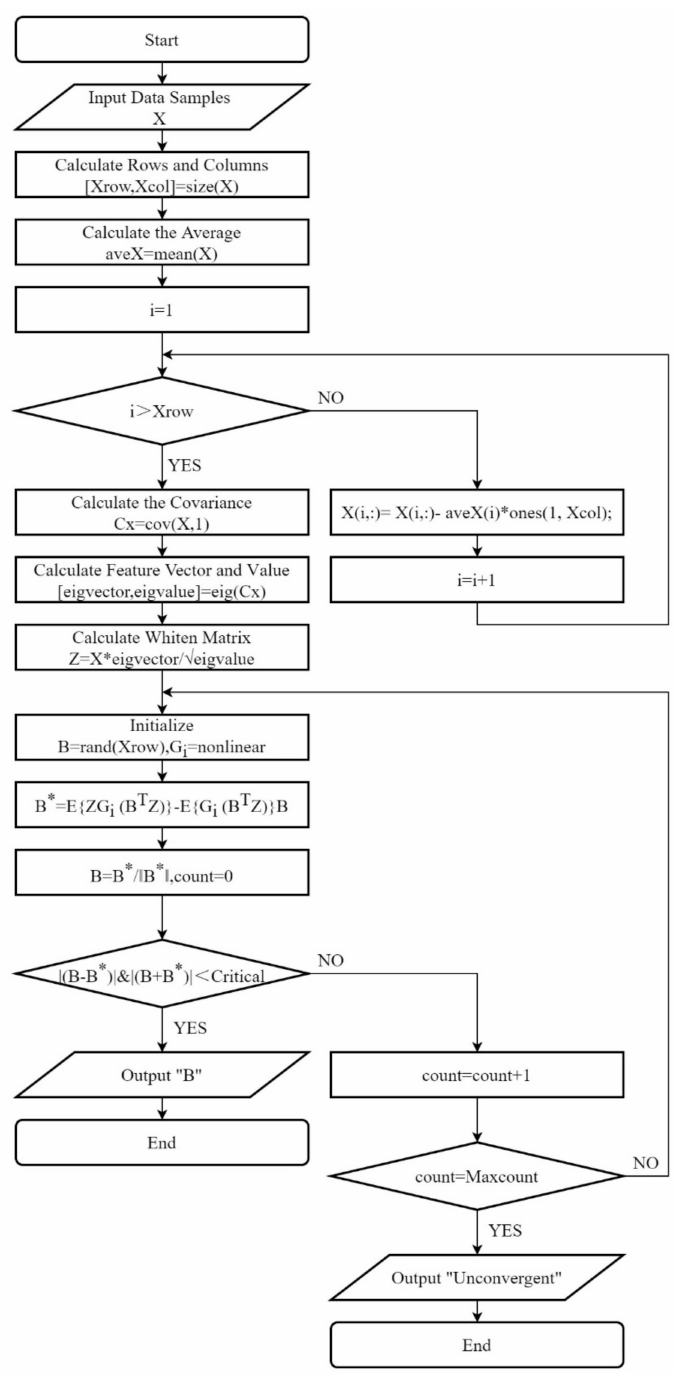
Figure 1. Improved ICA Flow